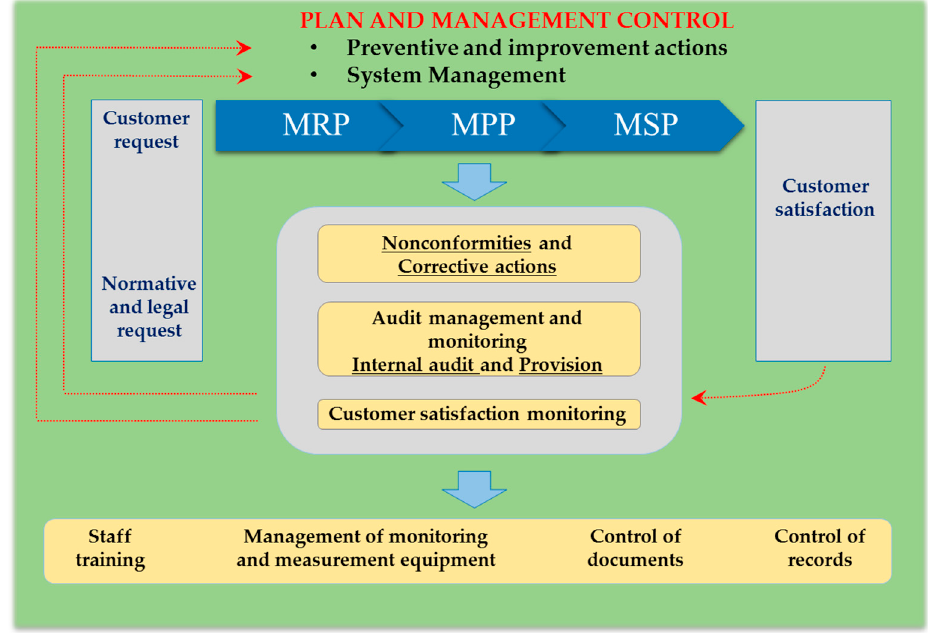
Figure 2. Model of key system areas of ISO 9001 implemented at Micoteca da Universidade do Minho. Being MRP, MPP and MSP the defined processes; and all contents of yellowish orange boxes the defined procedures.